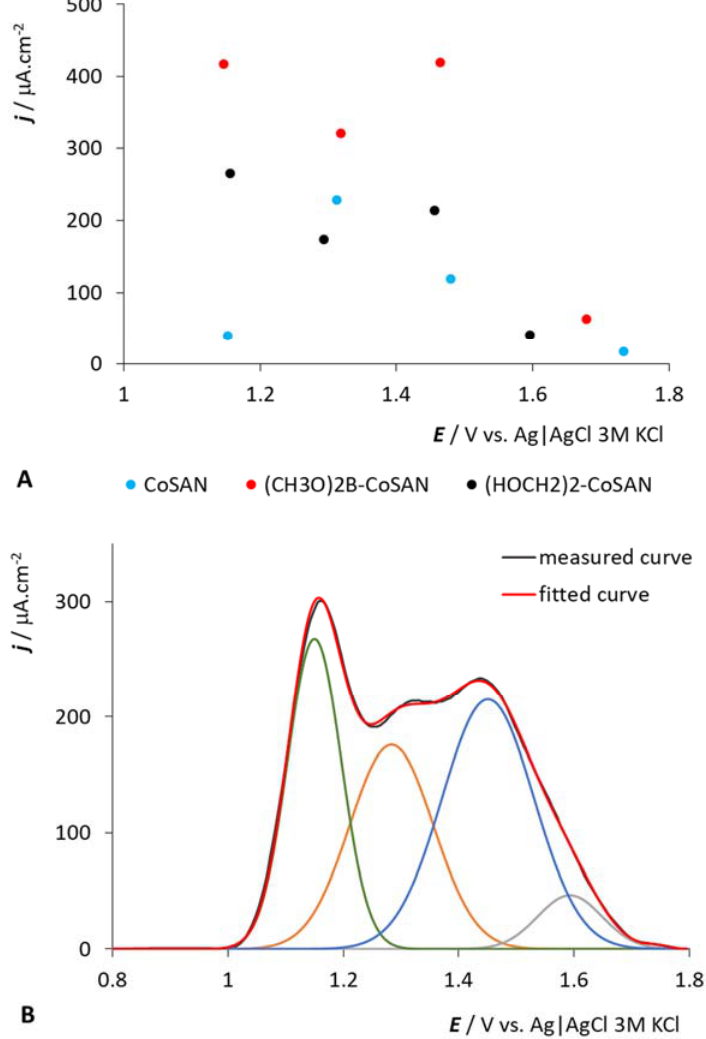
Figure 6. Deconvolution results (peak heights and position of fitted peaks) for the CoSAN , (HOCH2)2-CoSAN and (CH3O)2B-CoSAN [44] ( A ). Example of measured, sum of fitted peaks and individual fitted peaks for (HOCH2)2-CoSAN ( B ). All fitted curves were measured in PB of pH = 8, 500 µ M